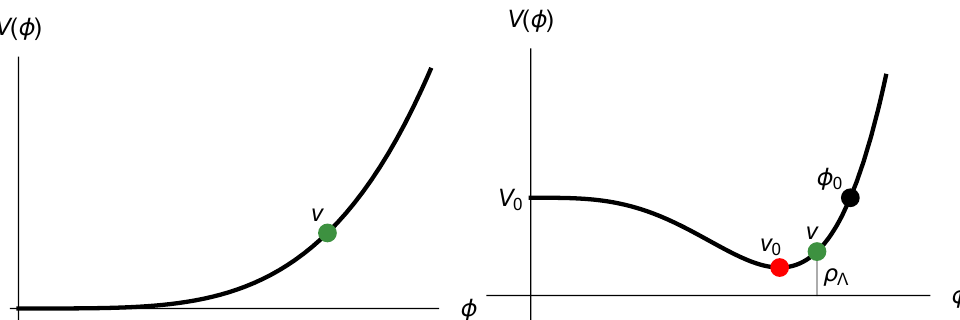
Figure 1 . Schematic depiction of the tree-level potential (left panel) with the (cid:12)xed point in green. The potential with quantum corrections is shown at right. The (cid:12)xed point v is displaced from the Coleman-Weinberg minimum v 0 due to spacetime curvature. In the linear approximation (3.19), the coupling (cid:21) (cid:30) runs through zero at (cid:30) 0 = e 1 = 4 v 0 . (cid:30) ( T = 0). Then (3.16) (cid:3) M